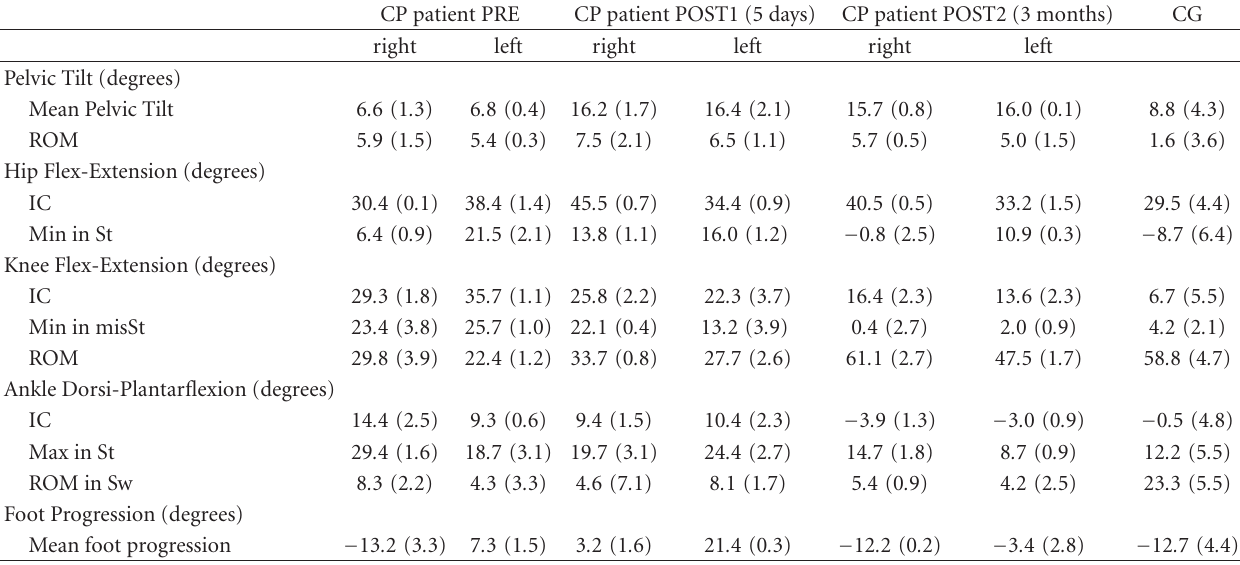
Table 1: Summary of kinematic parameters (mean and standard deviation) for analysed patient (CP patient; right and left side) in the examined sessions and normative data (Control Group, CG). ROM: Range Of Motion; Min: Minimum value; Max: Maximum value; IC: Initial Contact; St: Stance phase; Sw: Swing phase.